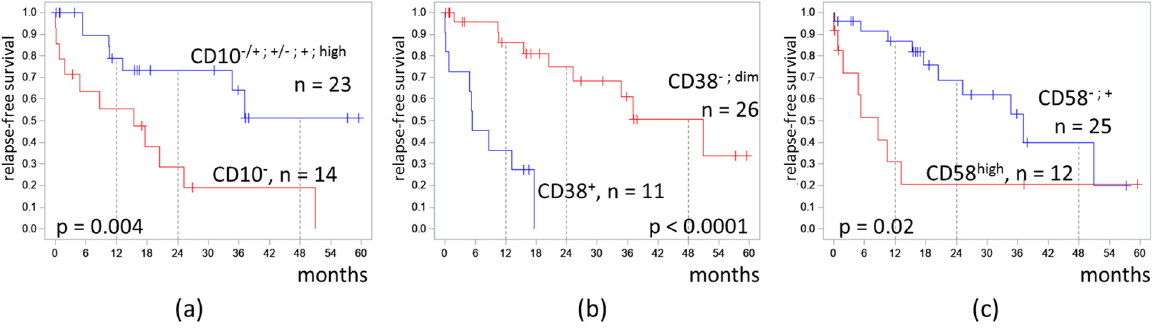
Figure 5. Relapse-free survival of patients depending on expression of CD10 ( a ), CD38 ( b ), and CD58 ( c ) on measurable residual blast cells detected at the end of induction. The initial date was the end of induction.